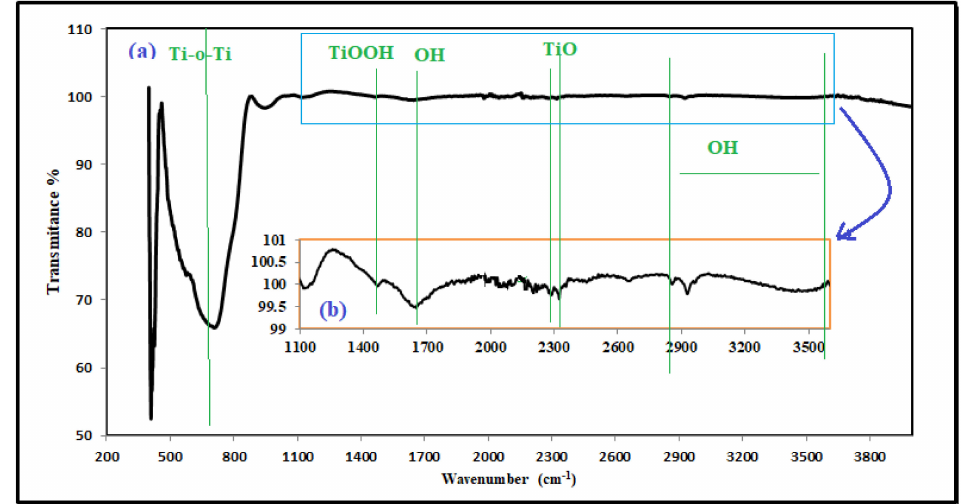
Figure 9. ( a ) TiO 2 FT − IR spectrum and ( b ) FT − IR scale up from 1100 to 3500 cm − 1